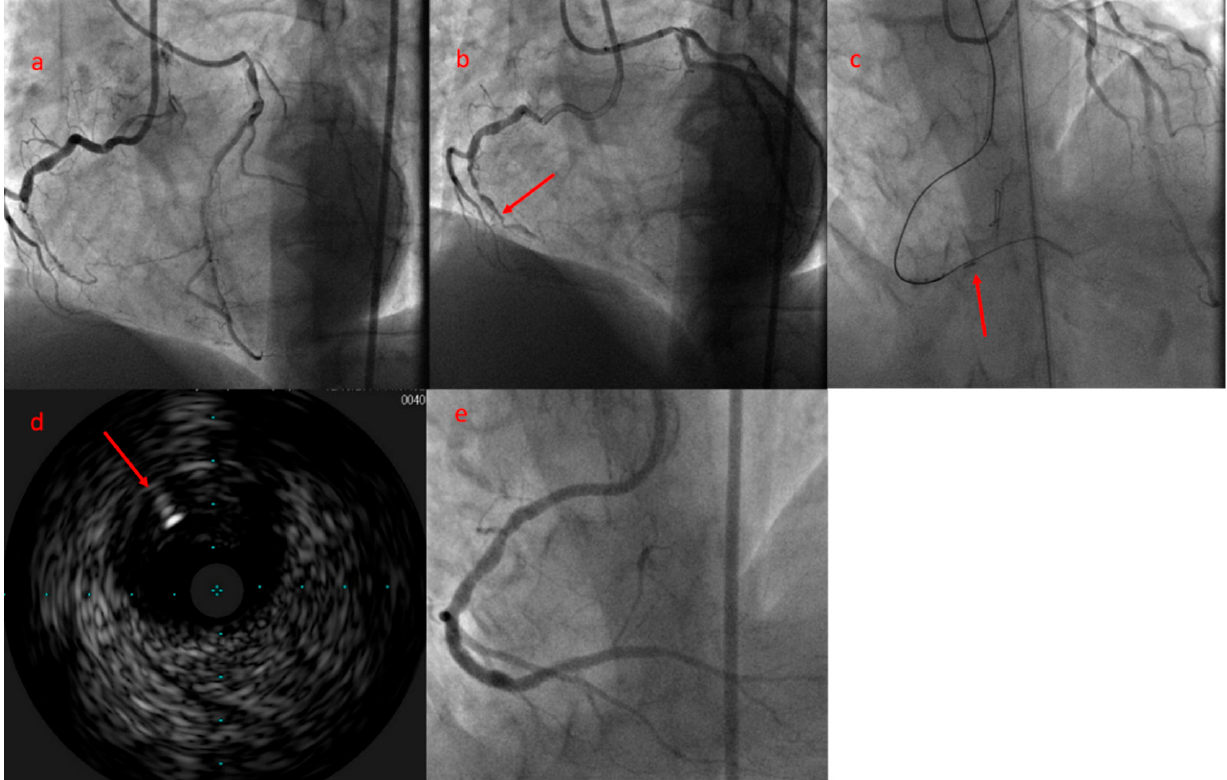
Figure 3. ( a ) Bilateral injection shows an RCA-CTO with 47 mm length. During the first attempt, balloon dilatation in CTO body as a bailout technique was used. ( b ) Coronary angiogram during the second attempt shows CTO body more visible, at least in its first segment (arrowhead), and the CTO length was reduced to 28 mm as a consequence of SPM in the previous procedure. ( c ) The antegrade wire navigated subintimally, and by positioning the IVUS probe in subintimal space (arrowhead), a new wire penetrated into true lumen. ( d ) IVUS shows that the true lumen is compressed between 9 and 12 o’clock, and a new dedicated wire is being penetrated into true lumen (arrowhead). ( e ) Final angiographic result. CTO: chronic total occlusion; RCA: right coronary artery; SPM: subintimal plaque modification.